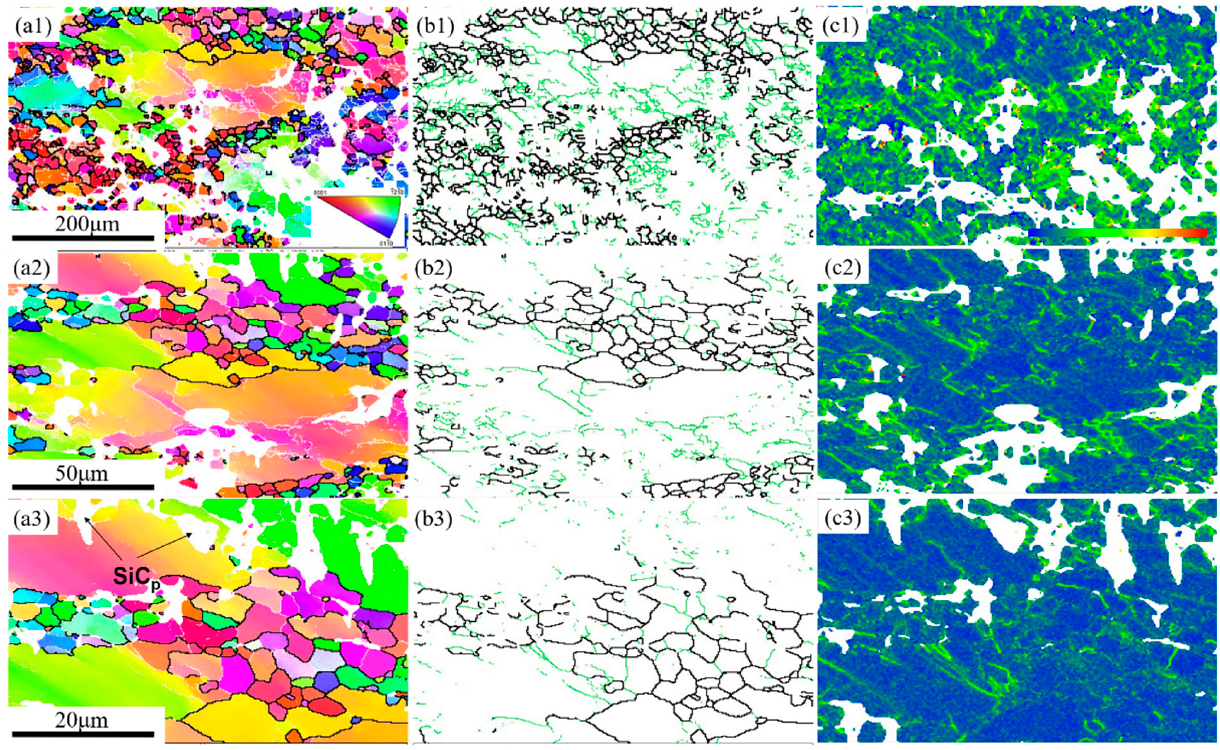
Figure 8. OM microstructures of the SiC p /Mg-5Zn material with compression strains of ( a , b ) 0.35 and ( c , d ) 0.7, the yellow box in ( d ) is the area away from particles and the white box in ( d ) is the area near the particles.